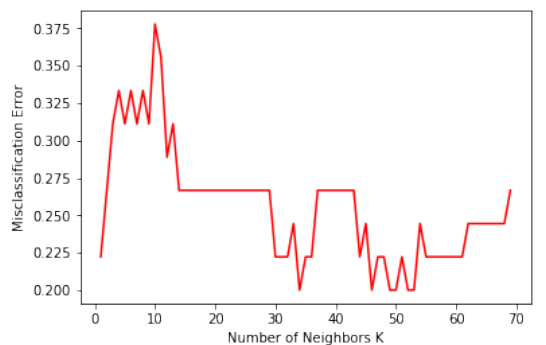
Figure 7. Misclassification Error along with Neighbors K